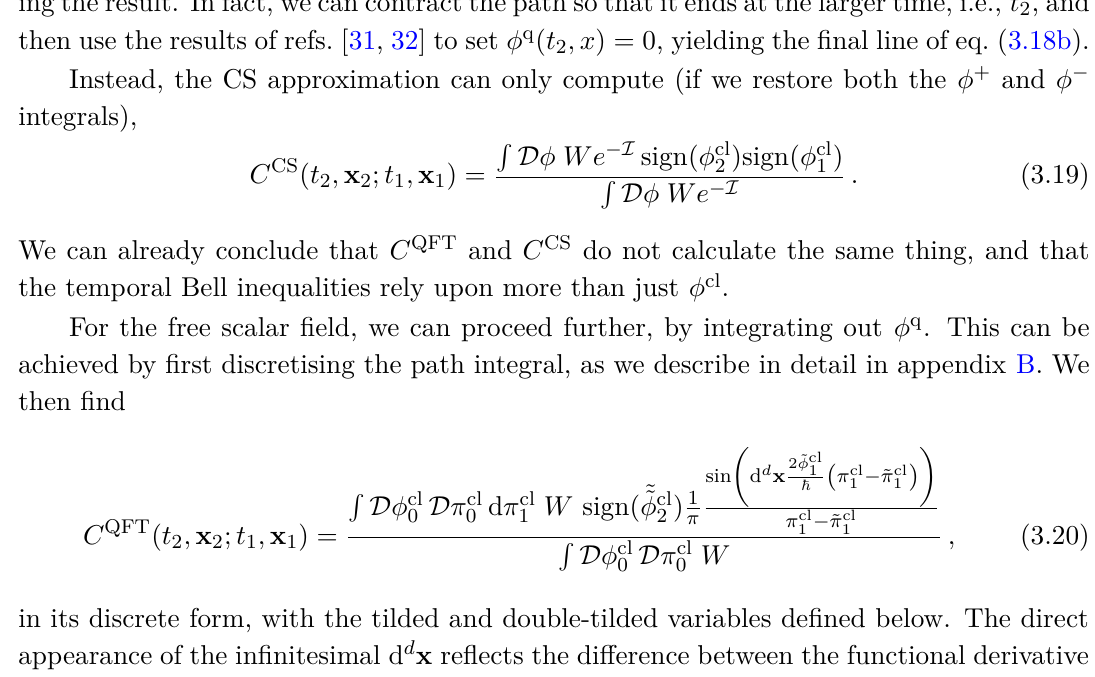
and t being the latest time on the 2 > t 1 m